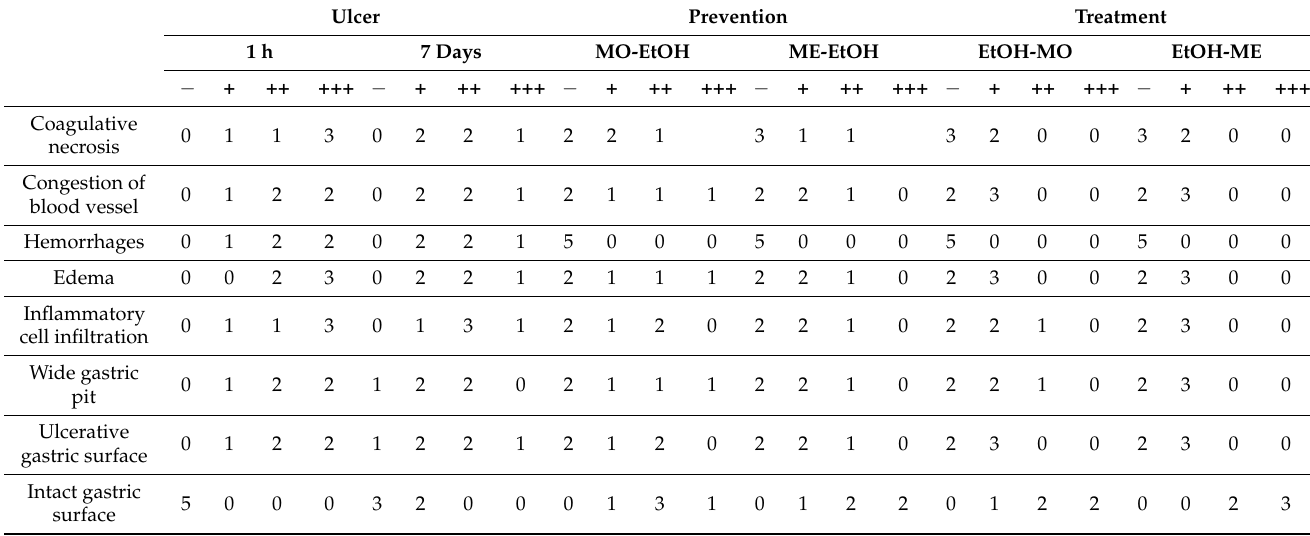
Table 4. Incidence and severity of histopathological lesions in the experimental groups.